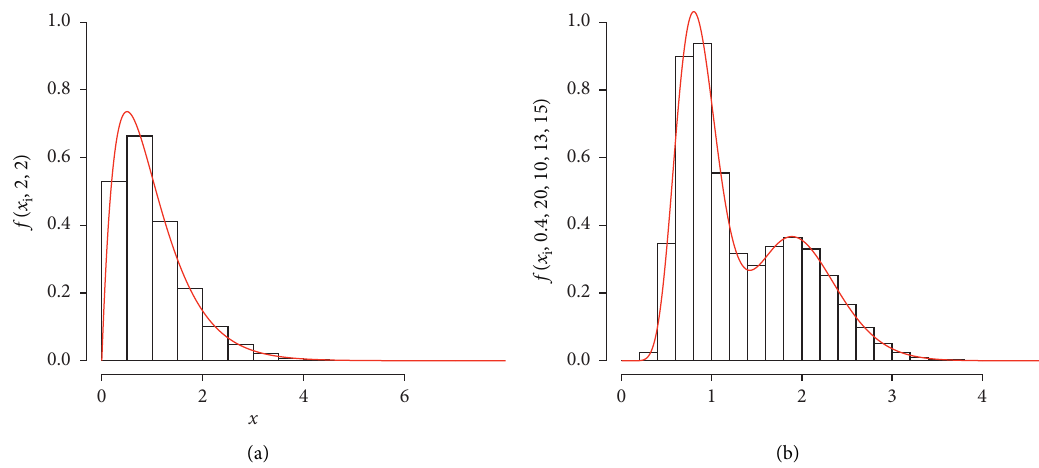
Figure 1: Examples of the scaled gamma distribution: (a) single distribution and (b) mixture of two